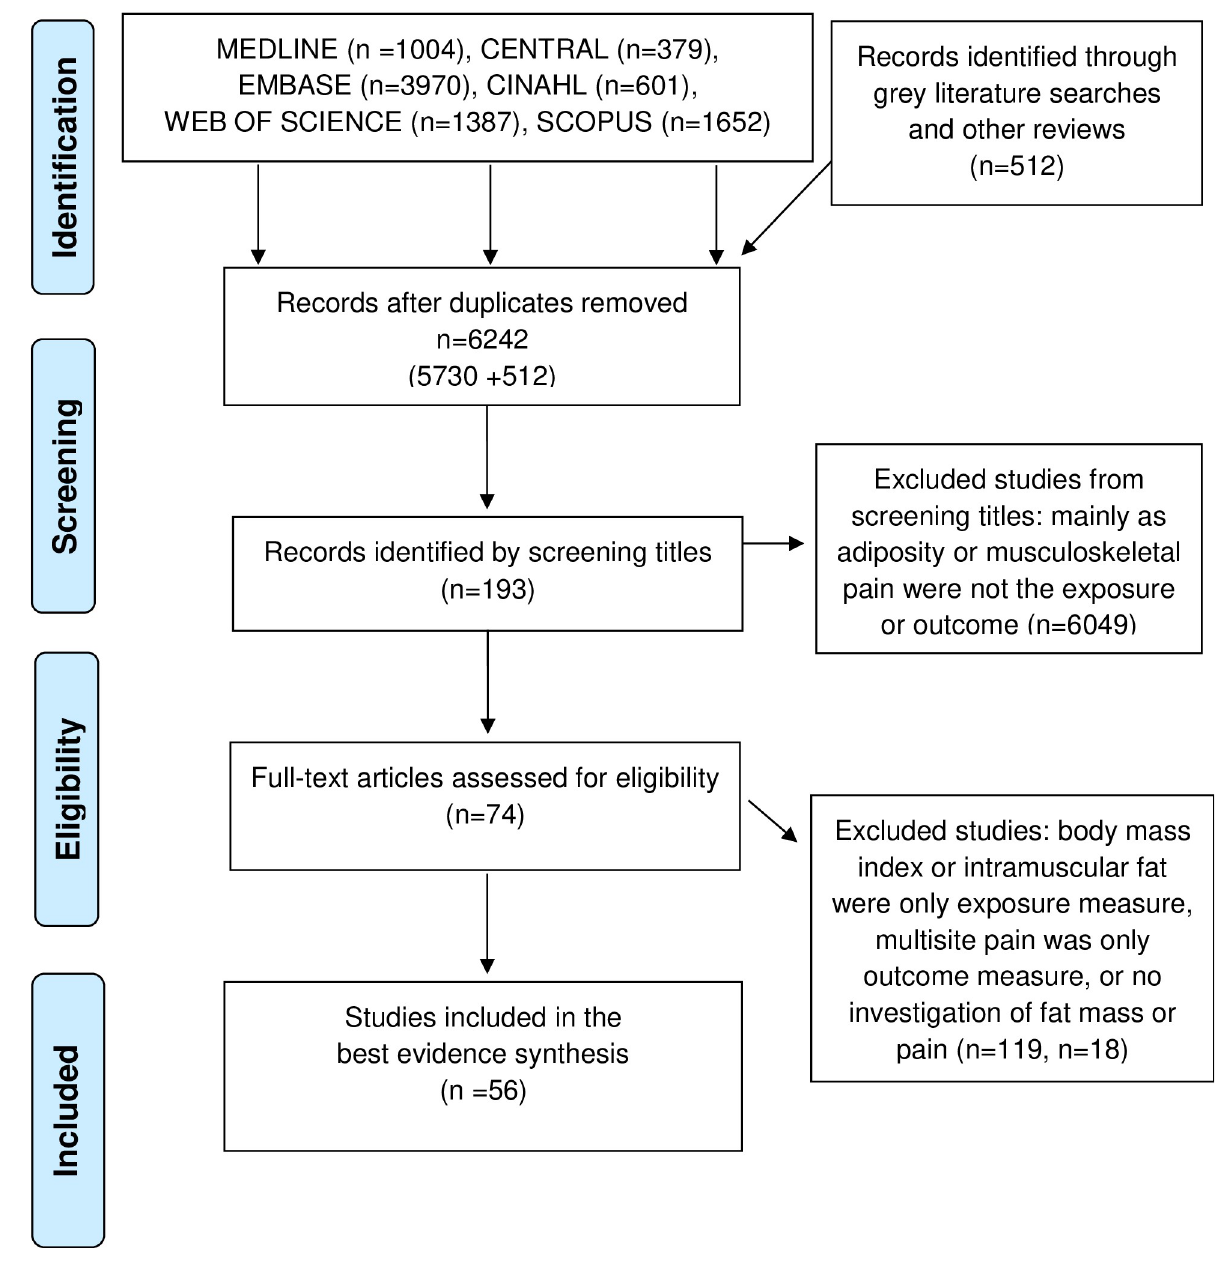
Fig 1. PRISMA flow